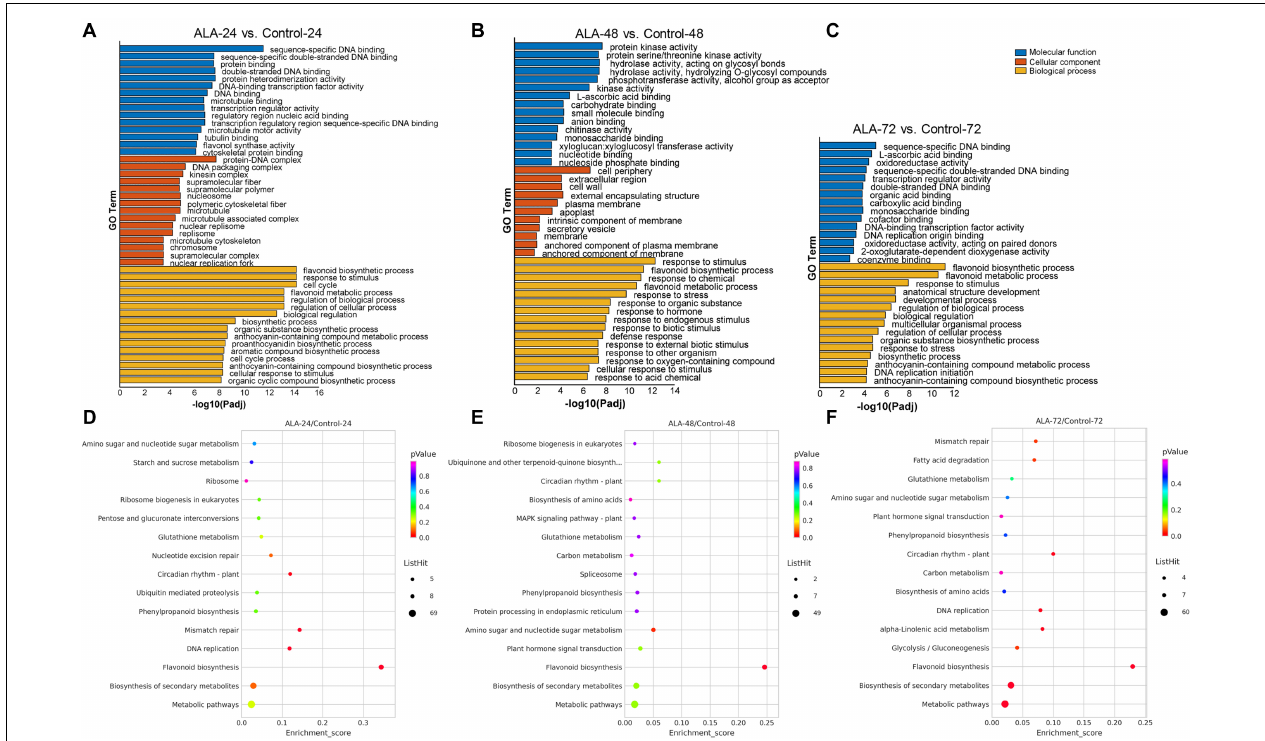
FIGURE 3 | Gene ontology (GO) classifications and KEGG pathways enrichment of DEGs. (A–C) GO categories assigned to DEGs in ALA-24 versus Control-24 (A), ALA-48 versus Control-48 (B) , and ALA-72 versus Control-72 (C) , respectively. The X -axis represents the negative –log 10 -transformed p values ( p-adj < 0.05) for differences between the samples. The left Y -axis shows categories according to the annotation of GO. (D–F) KEGG pathways of DEGs in ALA-24 versus Control-24 (D) , ALA-48 versus Control-48 (E) , and ALA-72 versus Control-72 (F) , respectively. The Y -axis and X -axis present the KEGG pathways and the enrichment scores, respectively. Dot size corresponds to the number of distinct genes, whereas dot color reflects the p-adj